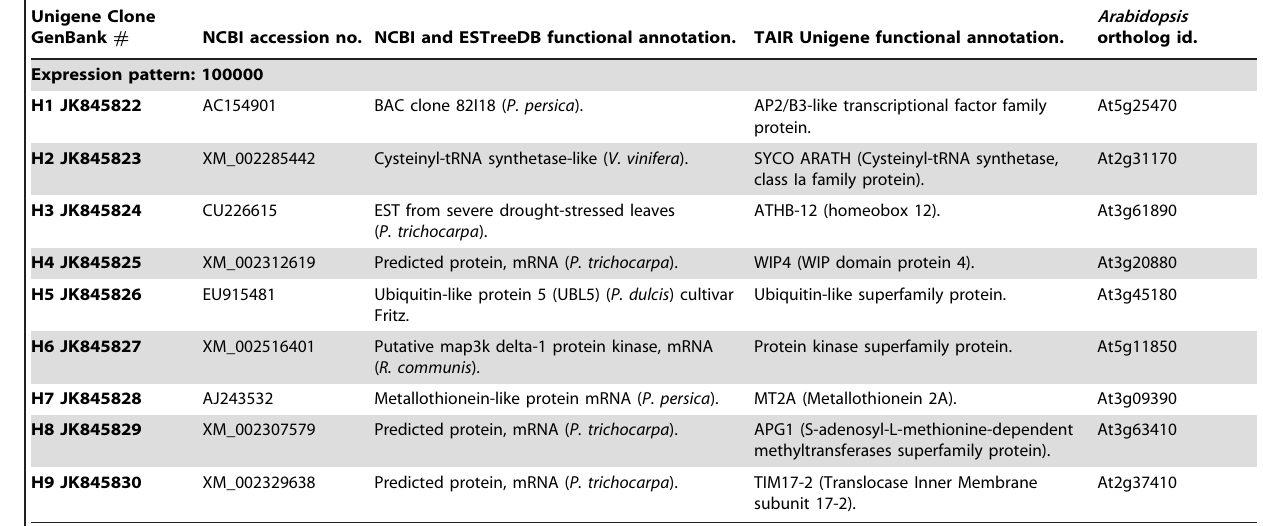
Table 5. Functional identity and gene ontology description of the isolated unigenes corresponding to the ‘‘Harvest Genes’’ (HG) unigenes.